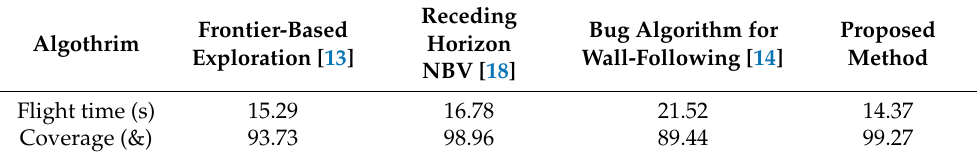
Figure 14. Apartment environment explored volume over time by four algorithms. Table 3. Theflight time and coverage comparisons of Frontier-Based Exploration, Receding horizon NBV, Bug algorithm for wall-following exploration algorithm with proposed frontier and sample- based exploration in apartment